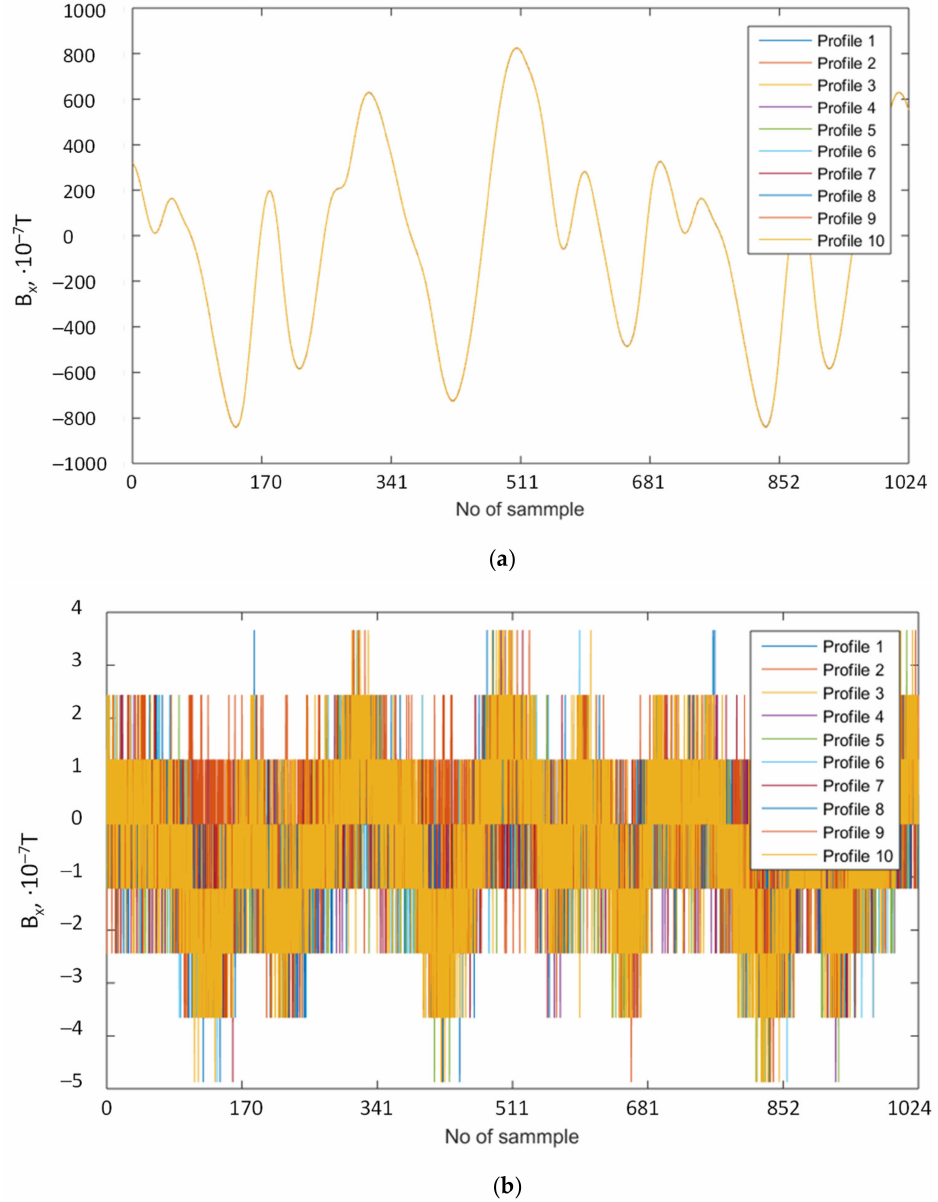
Figure 7. Magnetic profiles measured one after another in the same width of tread equal 100 mm for 205/60/R15/91 V tire ( a ) and differences between first and following profiles ( b ). Nine magnetic profiles are calculated as a differences of Bx values of the same